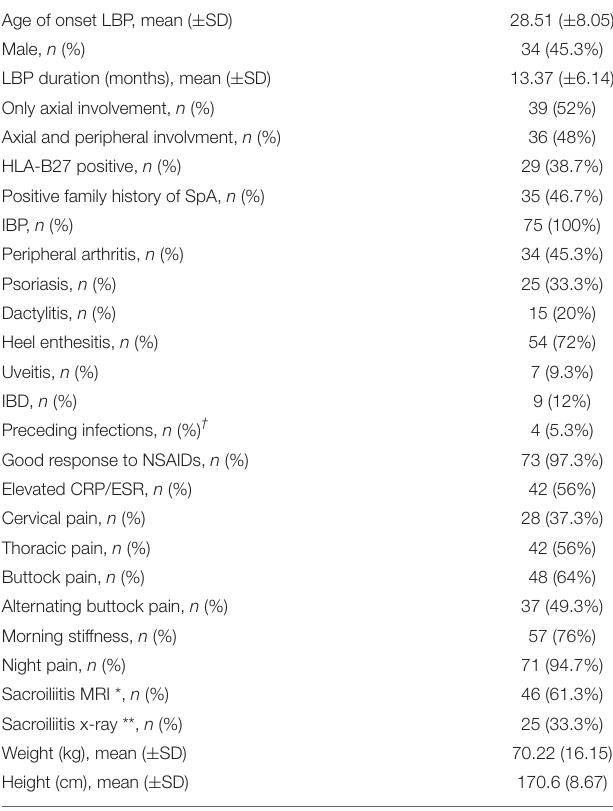
TABLE 1 | Baseline characteristics of LBP patients ( n =